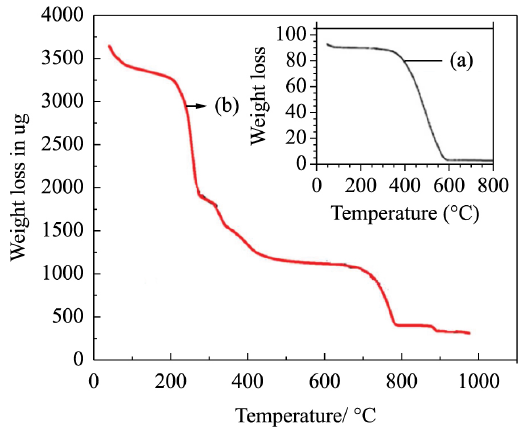
Figure 7. TGA curves of (a) pure PANI (b) PANI